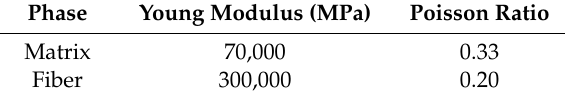
Table 2. Elastic properties of composites with three different volume fractions of fibers.